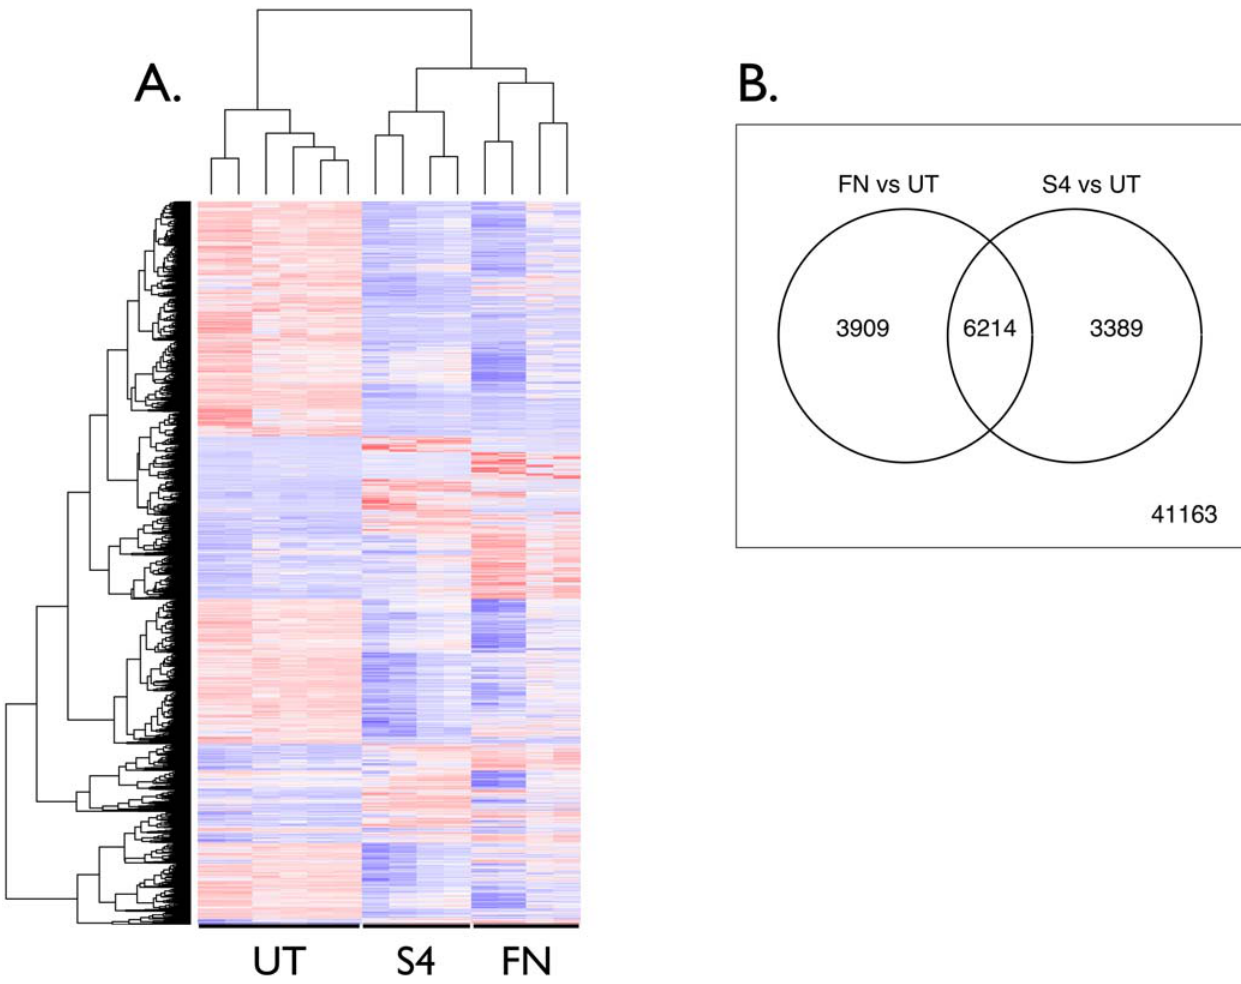
Figure 1. Transcriptional responses to F.novicida and F.tularensis Schu S4. A. Genes significantly different with an absolute fold change of 2 or greater after F. novicida or Schu S4 infection were pooled and used to create a heatmap. B. A Venn diagram of all significantly different genes that were up- or down-regulated twofold or more, with 6214 genes common to both strains, 3909 unique to FN, 3389 unique to S4 and 41163 counted as not different. FN: F. novicida (n=4). S4: Schu S4 (n=4). UT: untreated